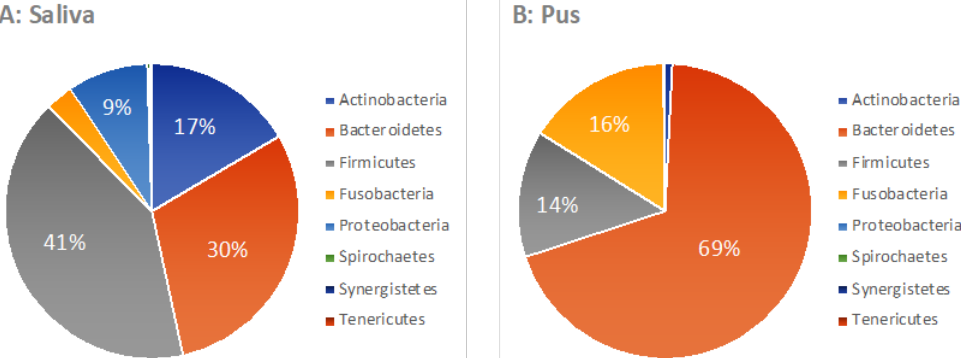
Figure 12. Phylum-level diversity of the oral microbiome ( A ) and the pus microbiome ( B ) ( n = 50).